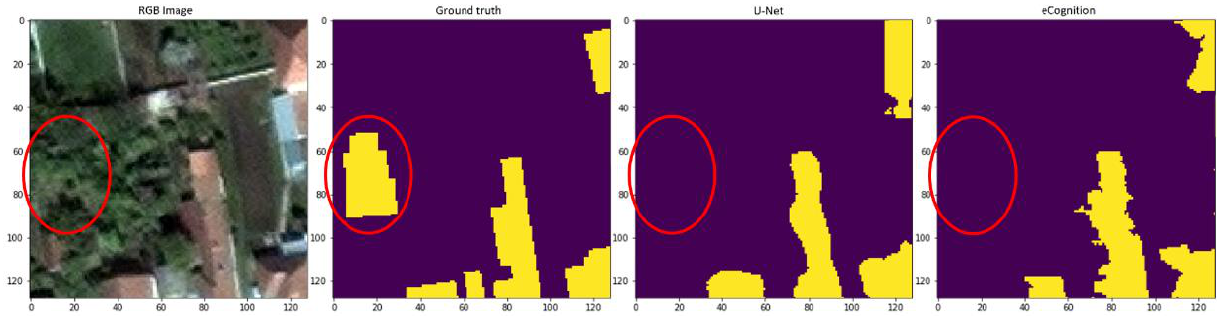
Figure 21. Non-existence of objects that are still registered in the real estate cadastre—Zrenjanin. 3.4.2. Objects That do Not Exist in Cadastre but Are Visible on the Orthophoto